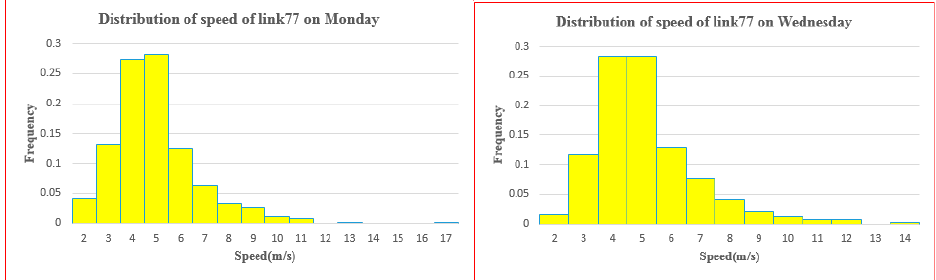
Figure 7. Distribution of speeds among the observations of link 82 on Monday and Wednesday.